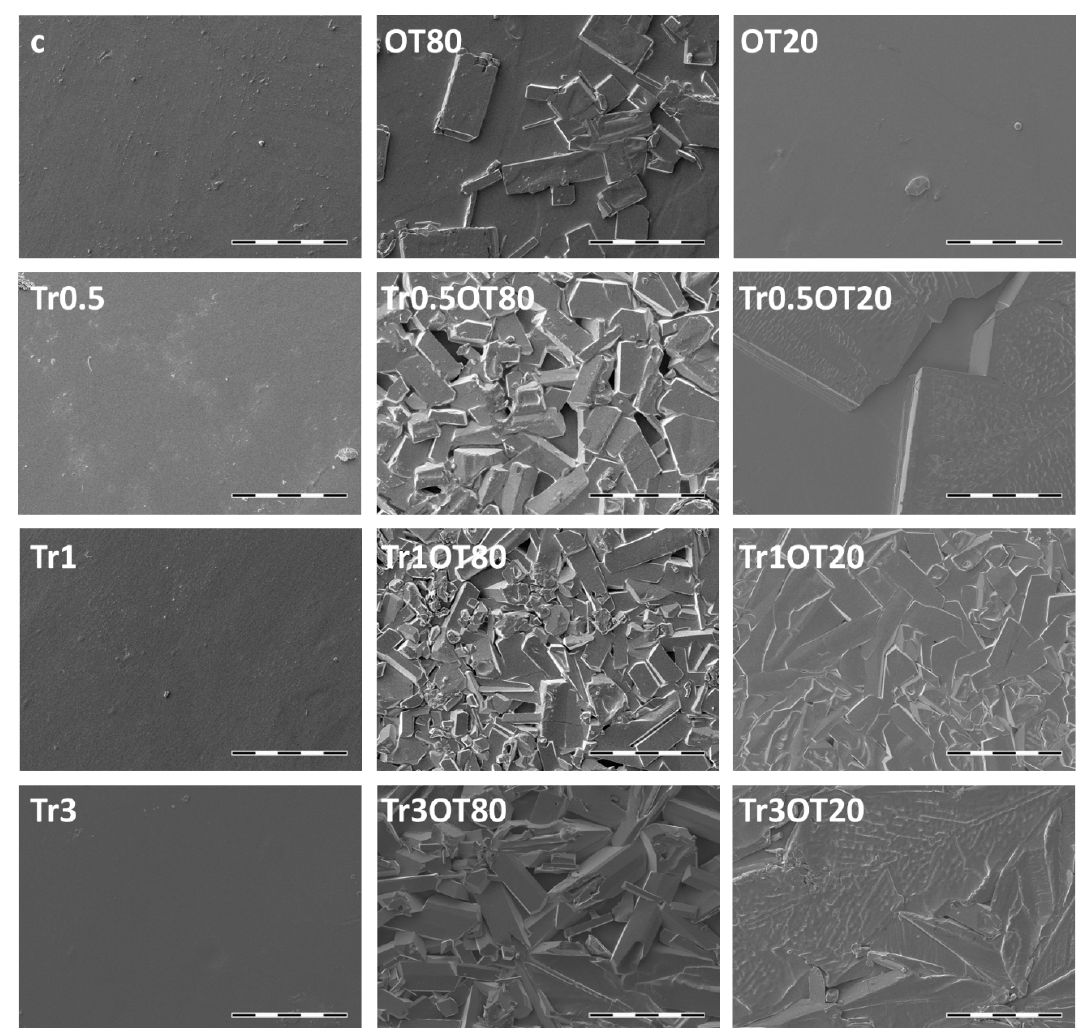
Figure 4. The SEM micrographs of films that consisted of 0.5 g of κ -carrageenan (voltage = 5 kV, current = 60 pA, scale bar = 100 µm).